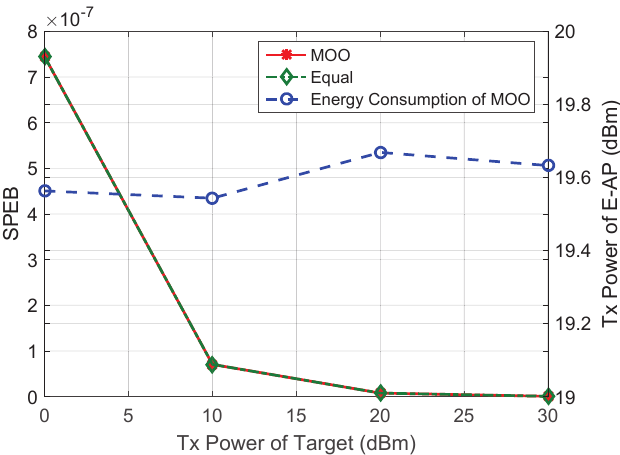
Figure 2. Optimal evaluation of the target transmit